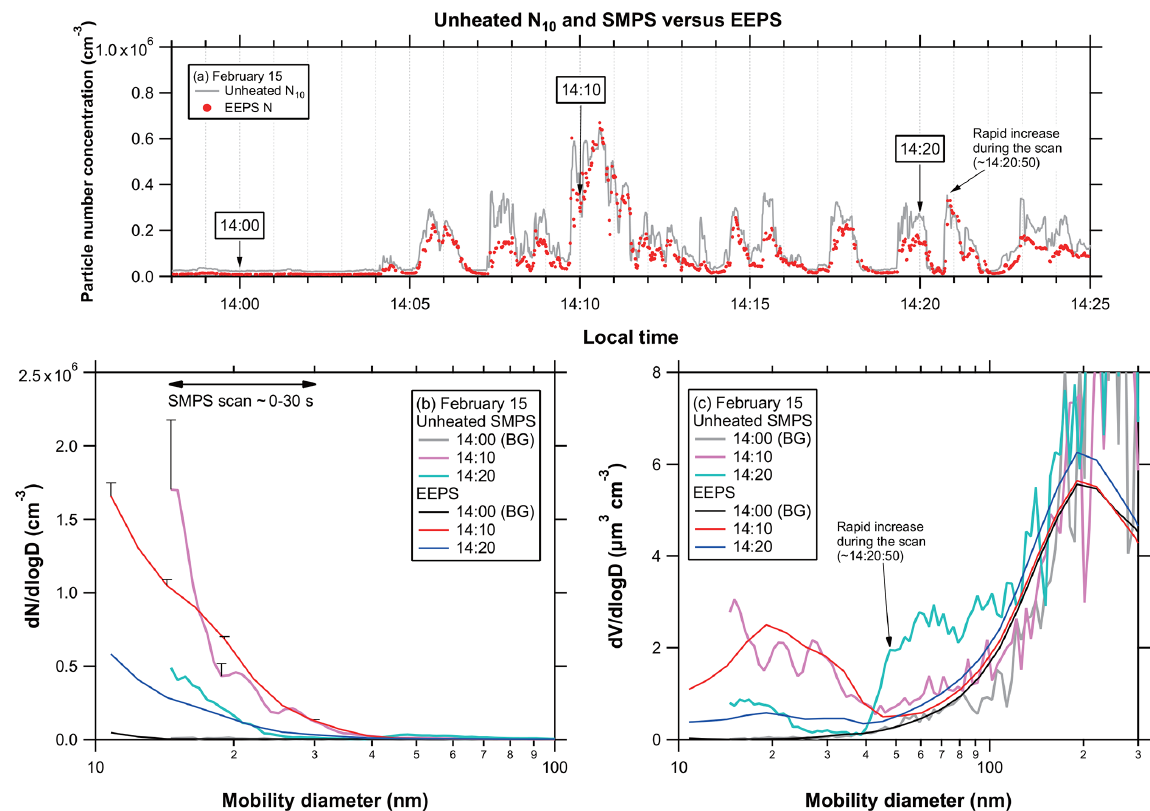
Figure 6. (a) Time series of unheated N 10 (gray) and total particle number concentrations derived from the EEPS data (EEPS N, red) obtained at 13:58–14:25LT on 15 February 2018. (b) Particle number size distributions measured simultaneously by the EEPS and unheated SMPS for selected time periods indicated in (a) . The EEPS data were averaged over 40s around the timing of the SMPS scan corresponding to the diameter range of 15–30nm (i.e., averaged from 10s before to 30s after the onset of each SMPS scan). “BG” denotes a time period without enhancements of the aerosols and CO 2 . The upper ends of the error bars indicate the particle number concentrations incorporating the penetration efficiencies of particles through the sampling tubes shown in Fig. S1. (c) Same as (b) but for the particle volume size